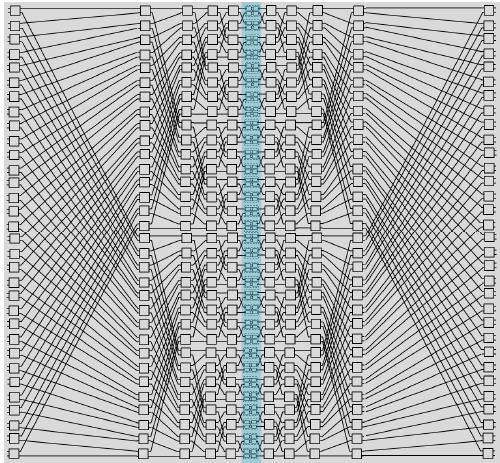
Figure 5. Topology of 32 × 32 Hybrid Dilated Benes.